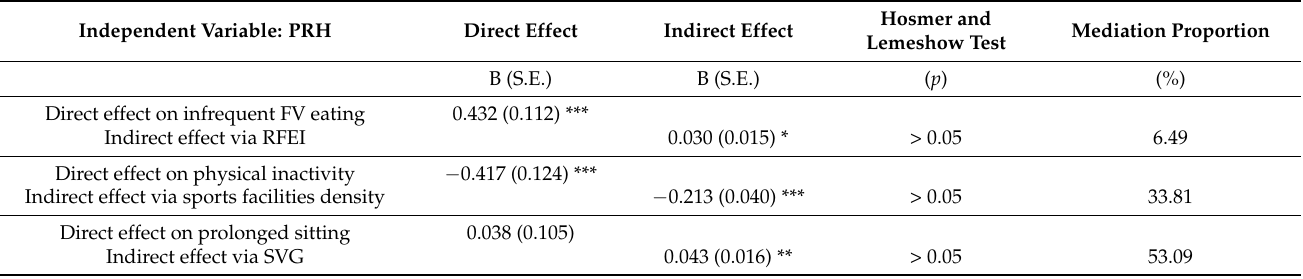
Table 4. Mediation results of direct and indirect effect from PRH residence to obesogenic behaviors via food environment and physical activity environment among adults in Hong